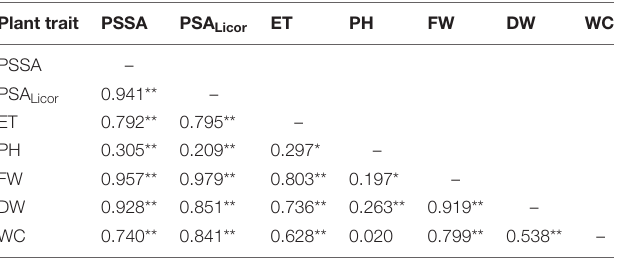
TABLE 4 | Results of the bivariate Pearson correlation analysis of the plant phenotypic traits measured at the end of the experiment (T f ): projected shoot system area (PSSA), total plant shoot area with Licor area meter (PSA Licor ), evapotranspiration (ET), plant height (PH), plant aboveground fresh weight (FW), dry weight (DW), and water content